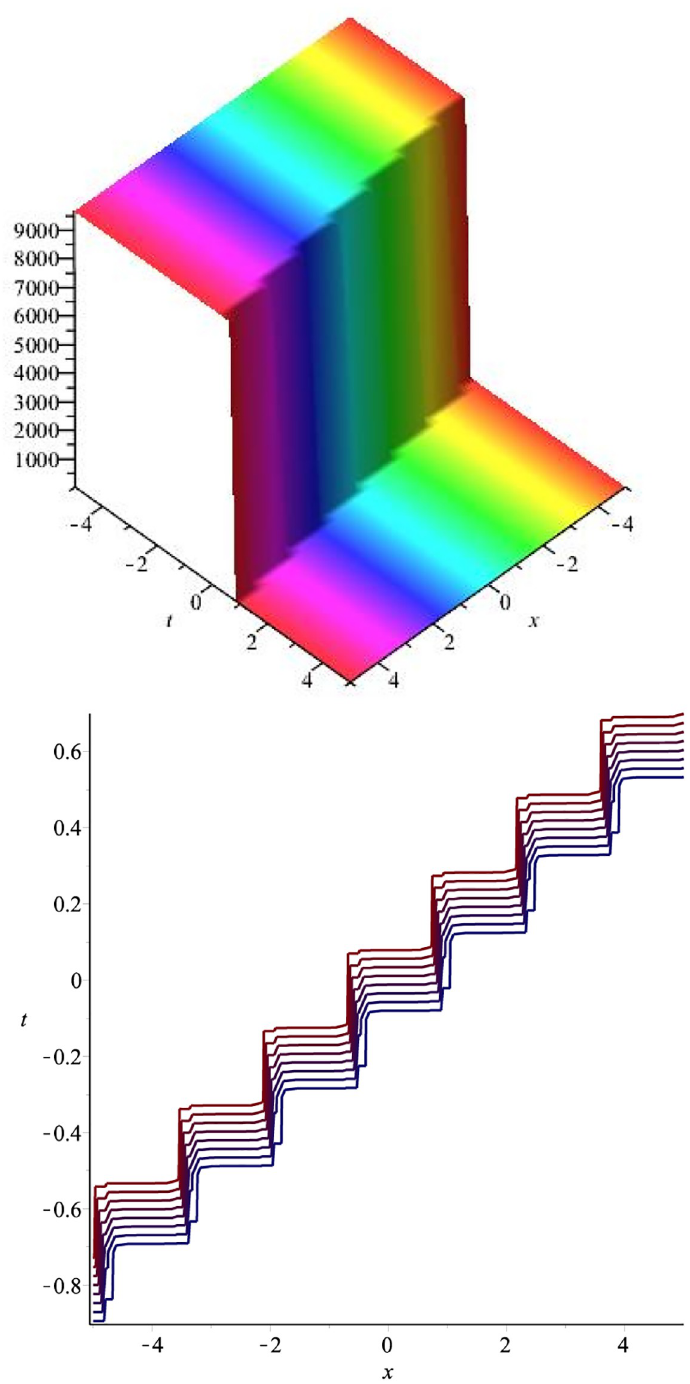
Fig 5. Kink soliton: j v 20 ( x , t ) j for β = 2.5, v = 7, λ = 3.7, μ = − 3.2, H 1 = 1.5, H 1 = 1, l = 1.3, m = 2.6.